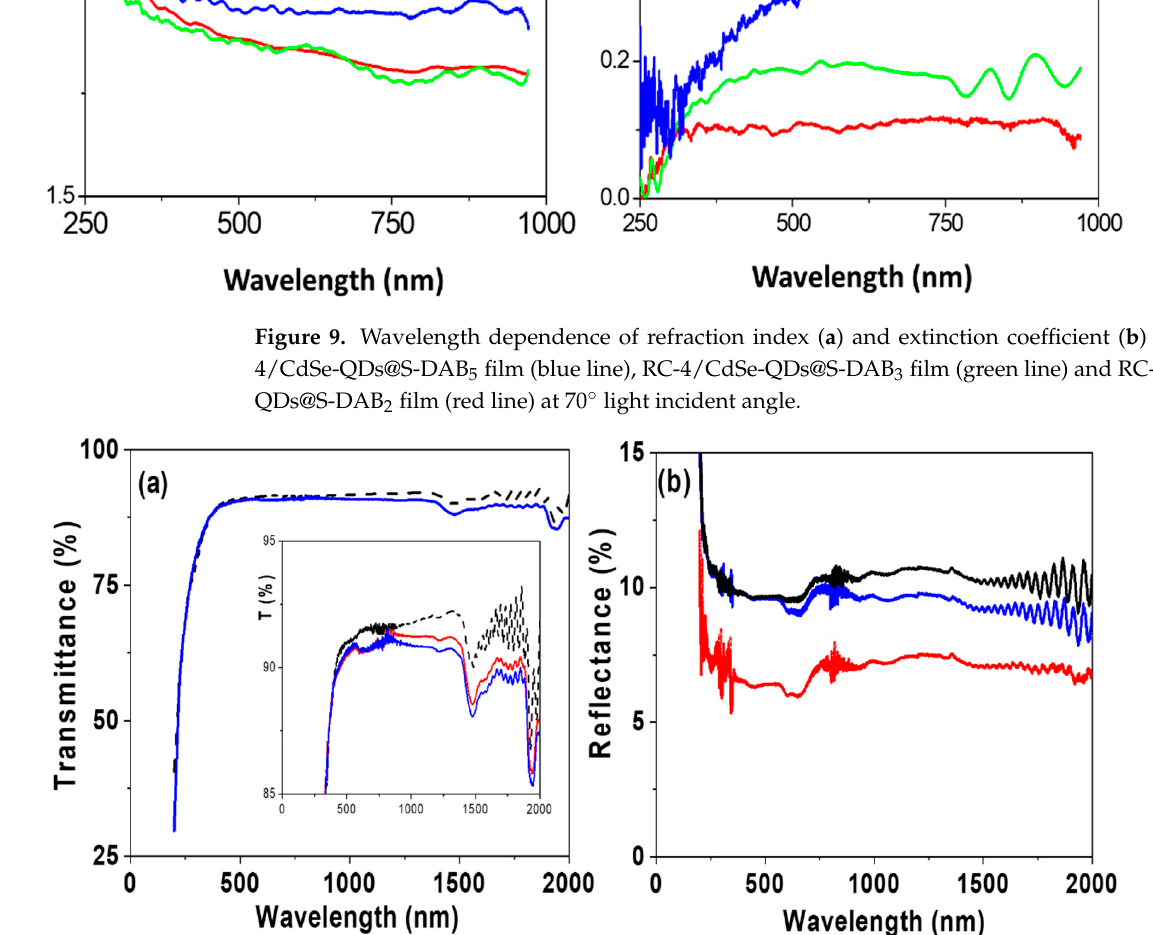
Figure 10. Wavelength dependence of: ( a ) light transmittance and ( b ) light reflection. RC-4 film (black line), RC-4/CdSe-QDs@S-DAB 5 film (blue line) and RC-4/CdSe-QDs@S-DAB 3 film (green line).